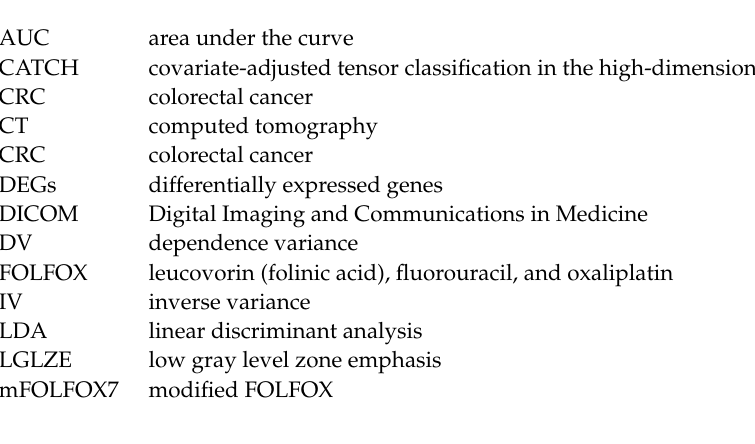
and clinical outcome; Figure S2: Boxplot and Kaplan–Meier survival curves comparing the risk of cancer recurrence and recurrence-free survival (RFS) among patients with adjusted radiomic features or without radiomic features; Table S1: Wavelets and LoG features per patient; Table S2: The spectrum of 1037 radiomic features; Table S3: Patients’ characteristics in recurrent and non-recurrent groups; Table S4: The clinical and genetic features in cancer patients; Table S5: The adjusted radiomic features in cancer patients; Table S6: The clinical impact of adjusted radiomic features; Table S7: The correlation of adjusted radiomics and RNA